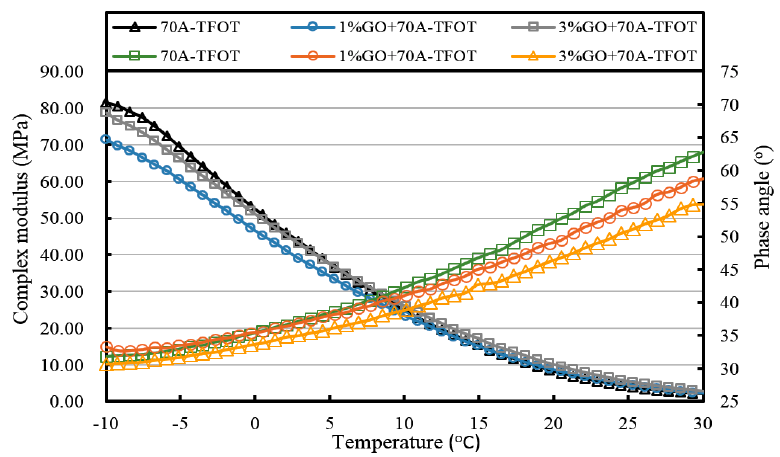
Figure 15. Complex modulus and phase angle of GO-modified 70A and its matrix at low temperature after TFOT aging.